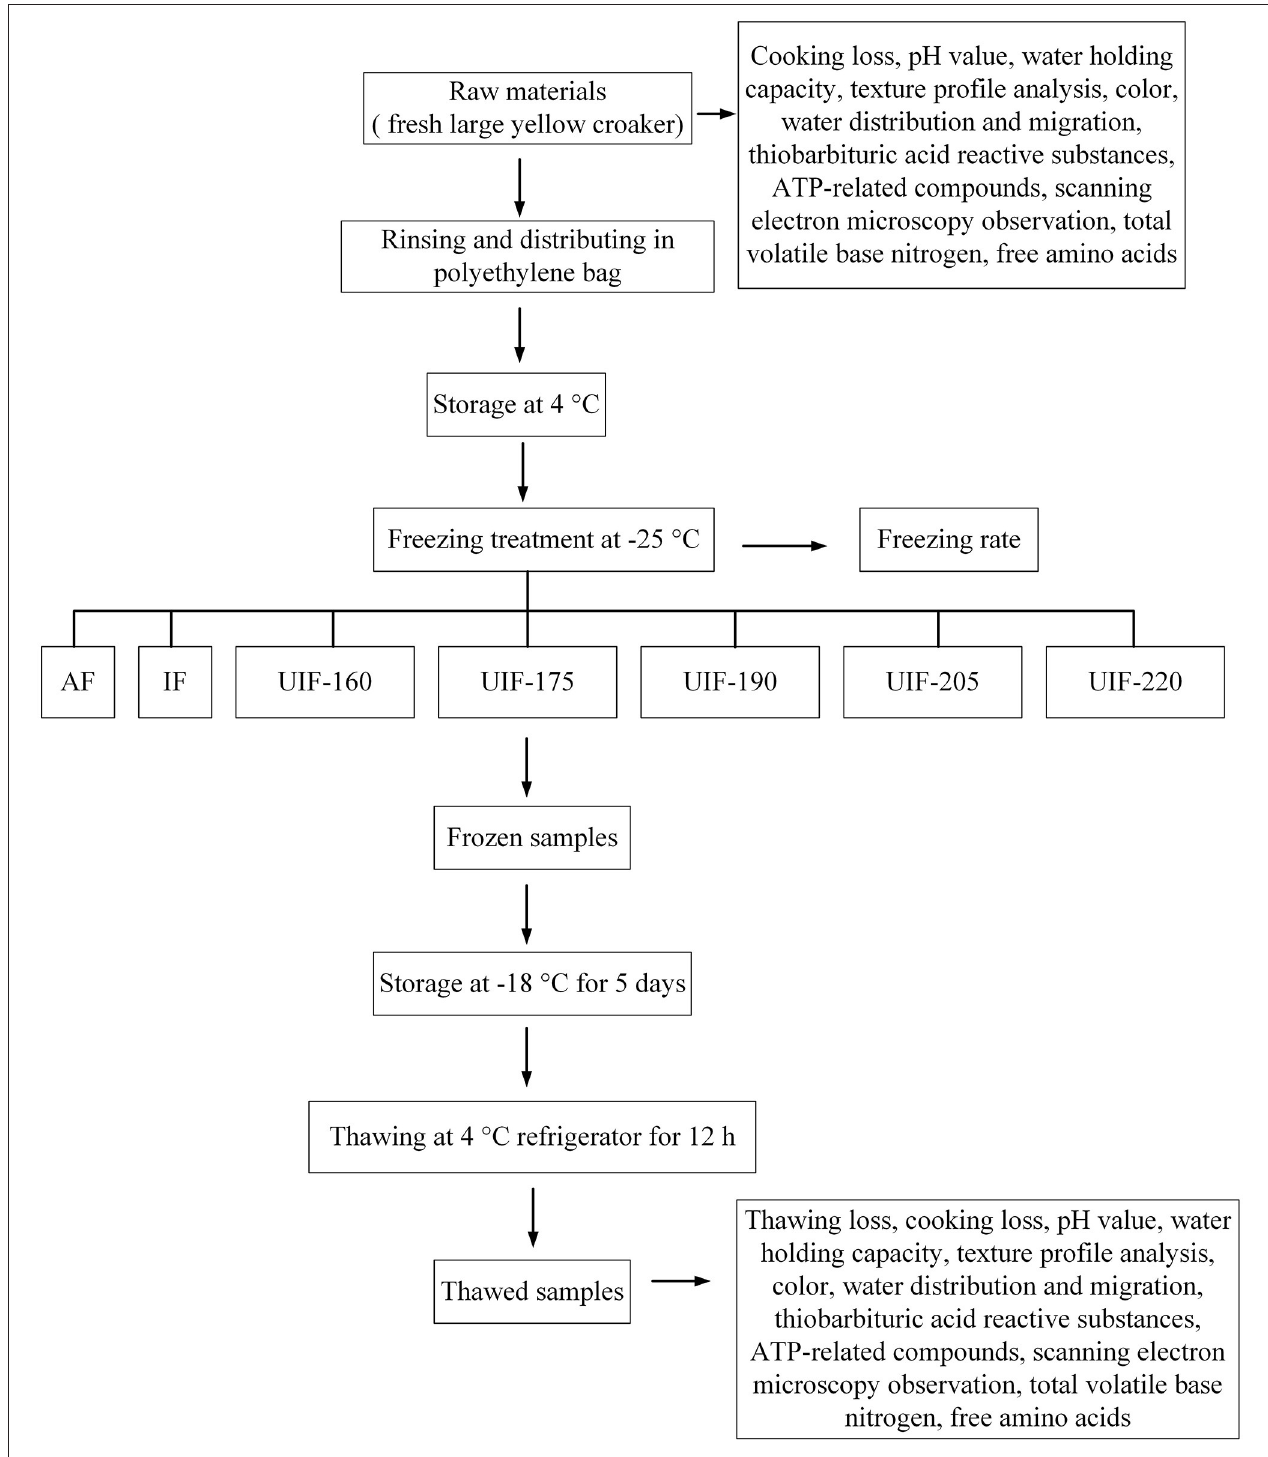
FIGURE 1 | Schematic diagram showing the experimental procedure.